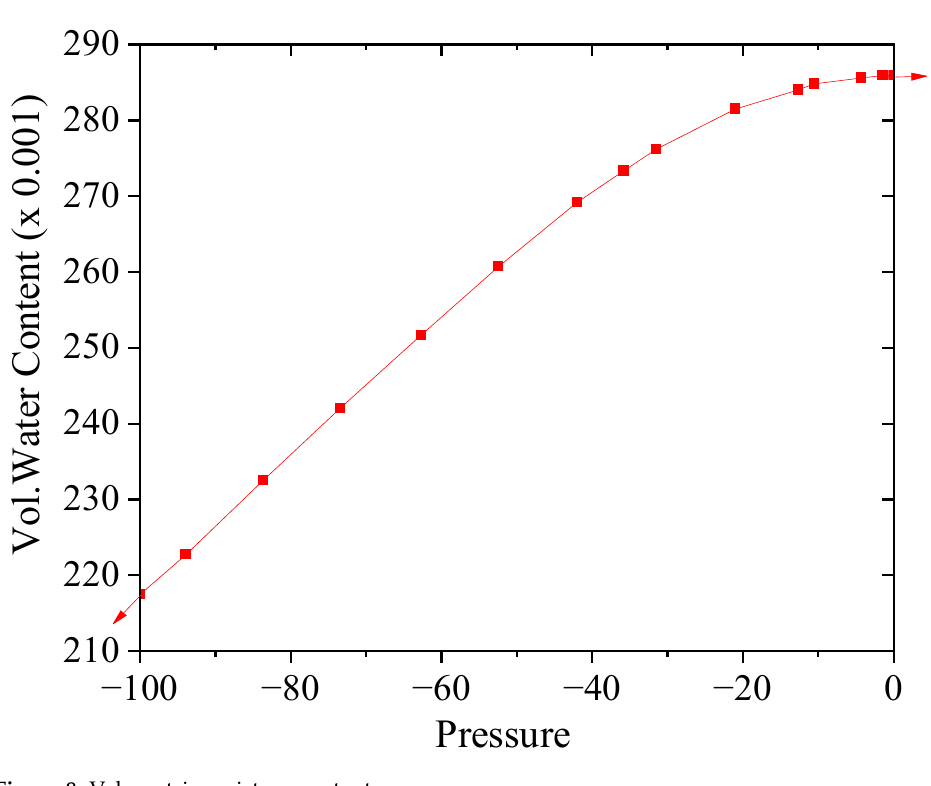
Figure 8. Volumetric moisture content.